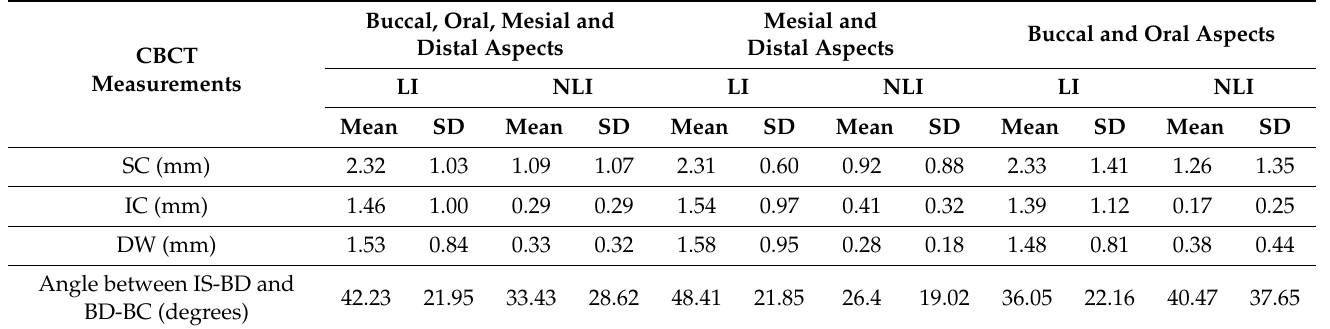
Table 2. CBCT measurements of buccal, oral, mesial and distal aspects, of mesial and distal aspects and of buccal and oral aspects in LI and NLI (means and